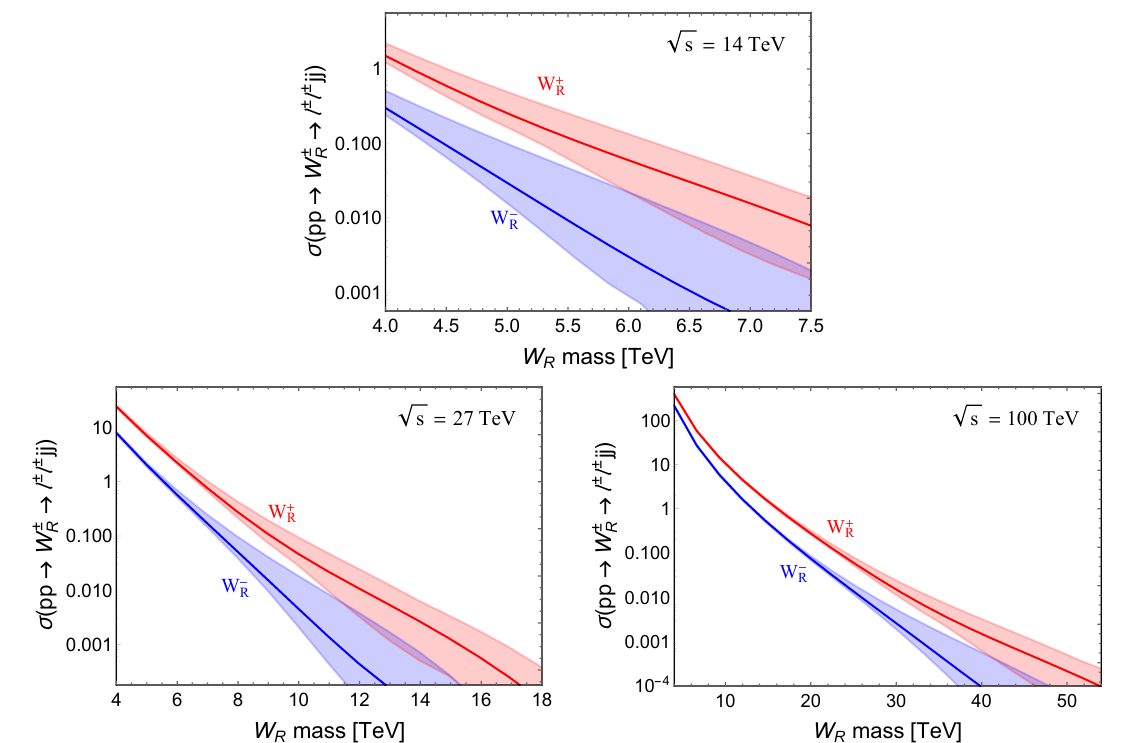
Figure 1. Parton-level, leading-order SS dilepton production cross section (cid:27) ( pp BR( W (cid:6) ‘ (cid:6) ‘ (cid:6) jj ) (with ‘ = e; (cid:22) ) at the 14 TeV LHC (upper), 27 TeV HE-LHC (lower left) R ! and 100 TeV FCC-hh (lower right), as a function of W R mass, with g R = g L . The solid red (blue) lines correspond to the central values for W + PDF